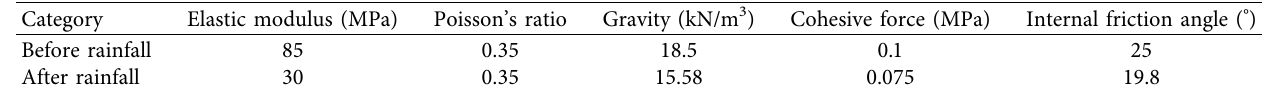
Table 2: Material